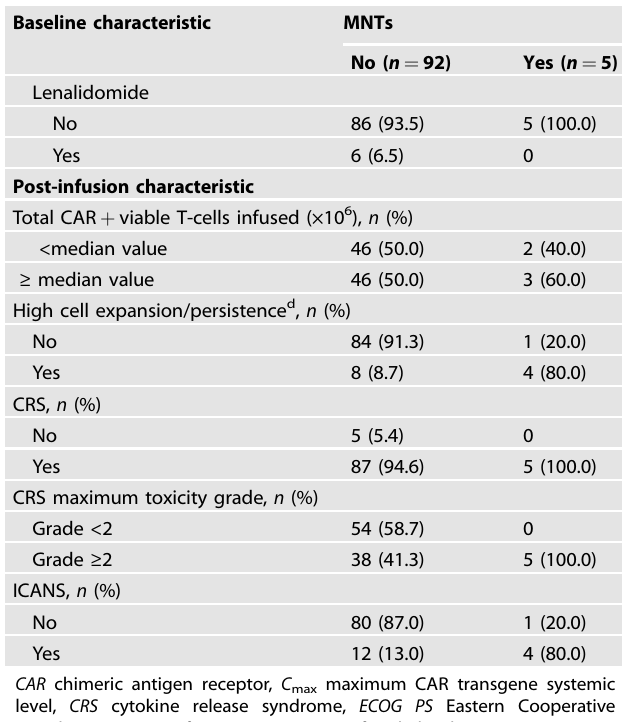
MNTs movement and neurocognitive treatment-emergent adverse events. a The last non-missing ECOG PS score on or prior to date of cilta-cel infusion was used; all patients met the inclusion criteria of ECOG PS score of 0 or 1 during screening. b Patients were categorized as having high tumor burden at baseline (prior to lymphodepletion) if they met any of the following: plasma cell in fi ltrate in the bone marrow ≥ 80%, serum M-spike ≥ 5 g/dL, serum free light chain ≥ 5000 mg/L. Those with low tumor burden had all of the following: plasma cell in fi ltrate in the bone marrow <50%, serum M-spike <3g/dL, and serum free light chain <3000 mg/L. Patients who did not fi t either criterion were categorized as having intermediate tumor burden. c Patient was